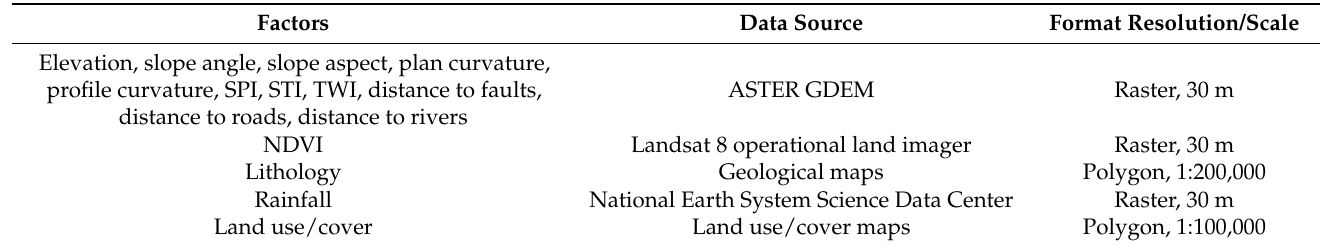
Table 2. Source and scale of conditioning